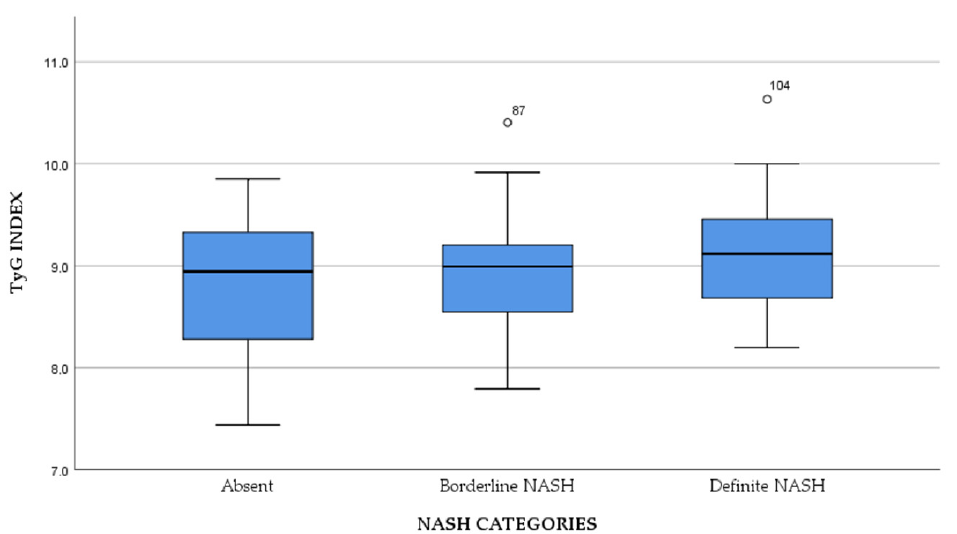
Figure 4. The study of TyG index in relationship with NASH categories.